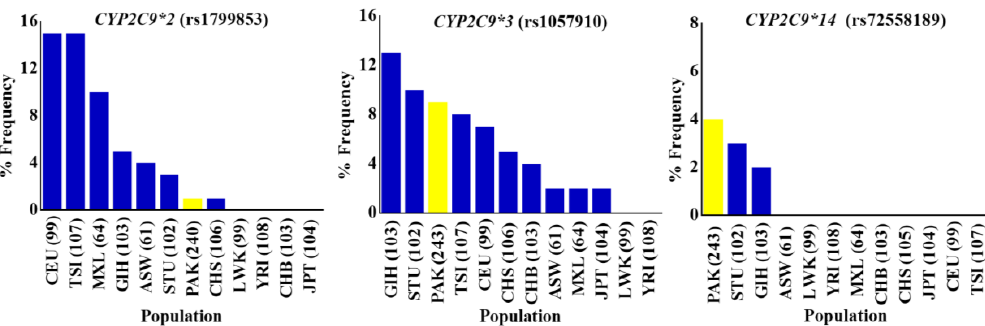
Figure 3. The allele frequency distribution of CYP2C9*2 , CYP2C9*3 , and CYP2C9*14 variants in indigenous Pakistani and global populations. Percentage allele frequency distributions of CYP2C9*2 (rs1799853), CYP2C9*3 (rs1057910) and CYP2C9*14 (rs72558189) pharmacogenetic variants in the Pakistani population and global populations from the 1000 Genome Project depicted in bar chart plots. Frequencies in the Pakistani population are shown in yellow, while others are represented by blue colored columns in the order of decreasing variant allele percentage frequency. The CYP2C9*2 , CYP2C9*3 , and CYP2C9*14 three CYP2C9 missense variants associated with reduced enzyme